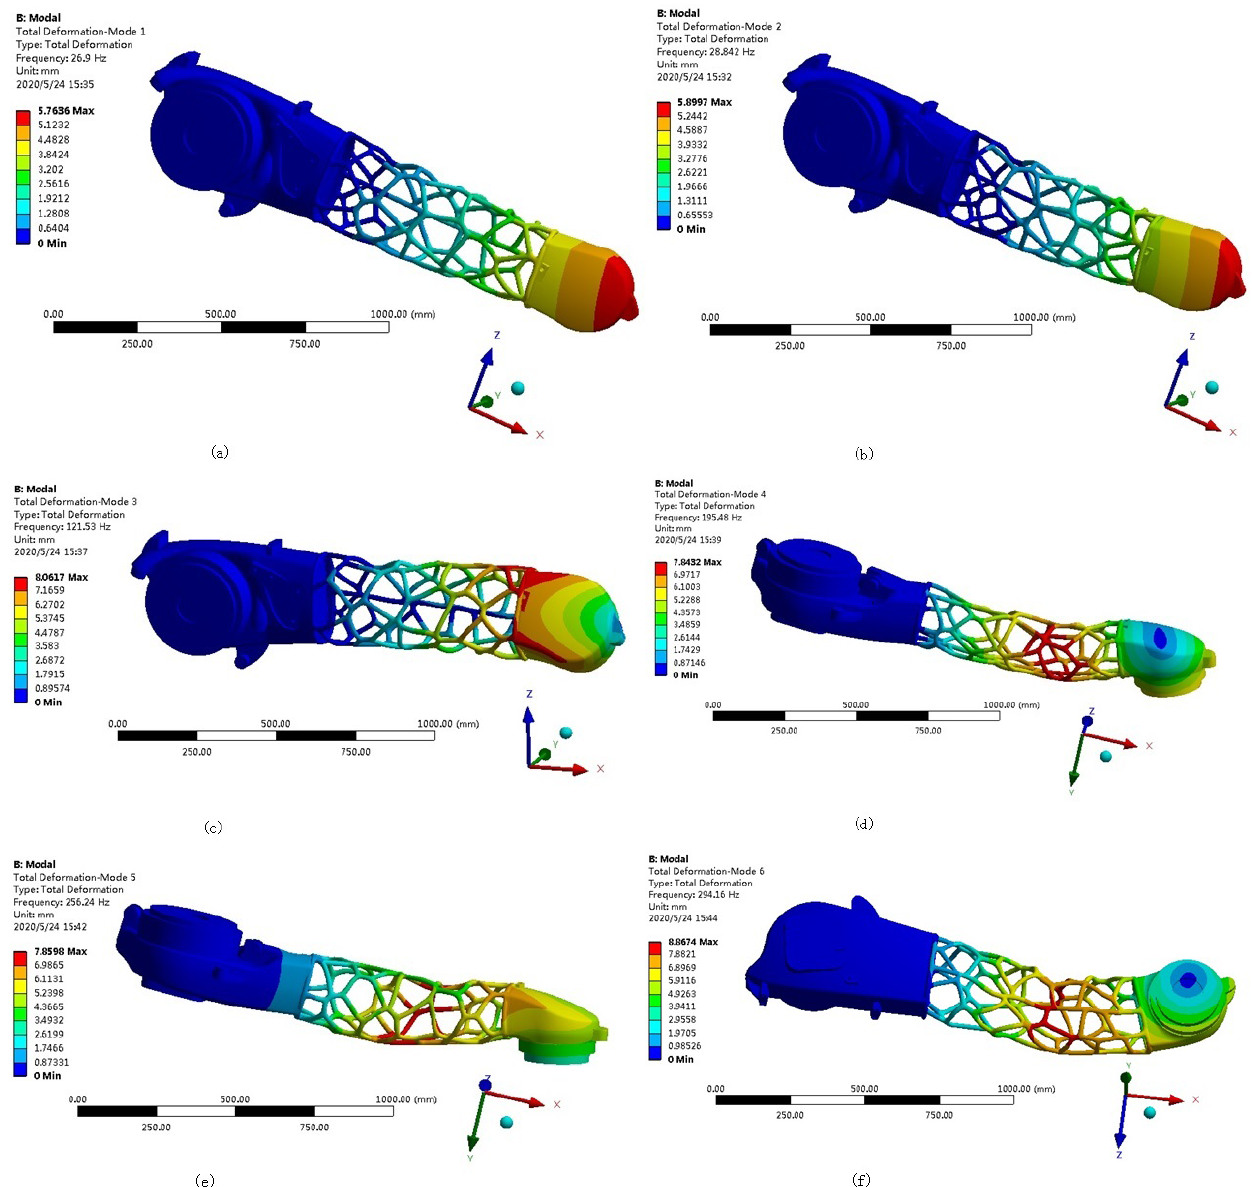
Figure 18. First six-order modes of the nested external removal: (a) first-order mode; (b) second-order mode; (c) third-order mode; (d) fourth-order mode; (e) fifth-order mode; (f) sixth-order